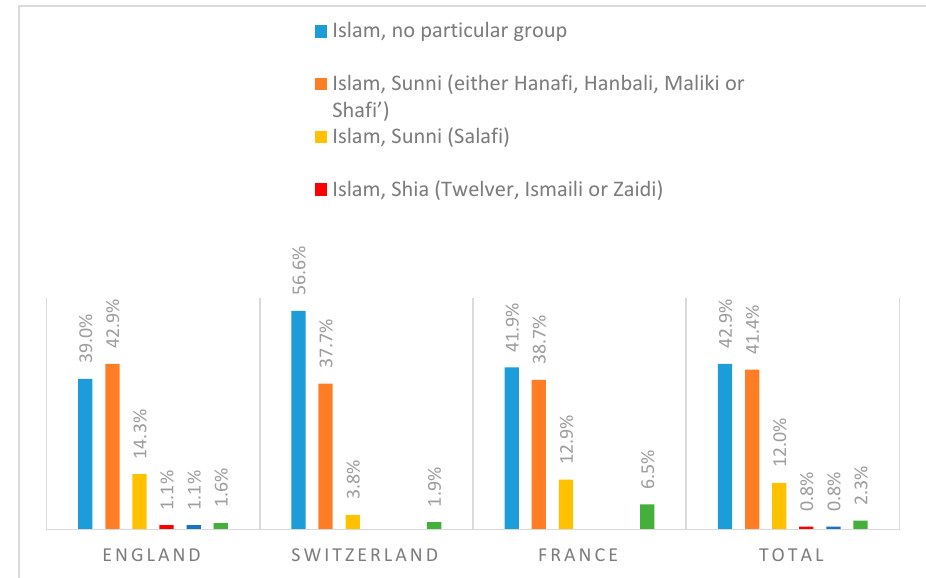
Figure 3. Denominational affiliation within Islam.